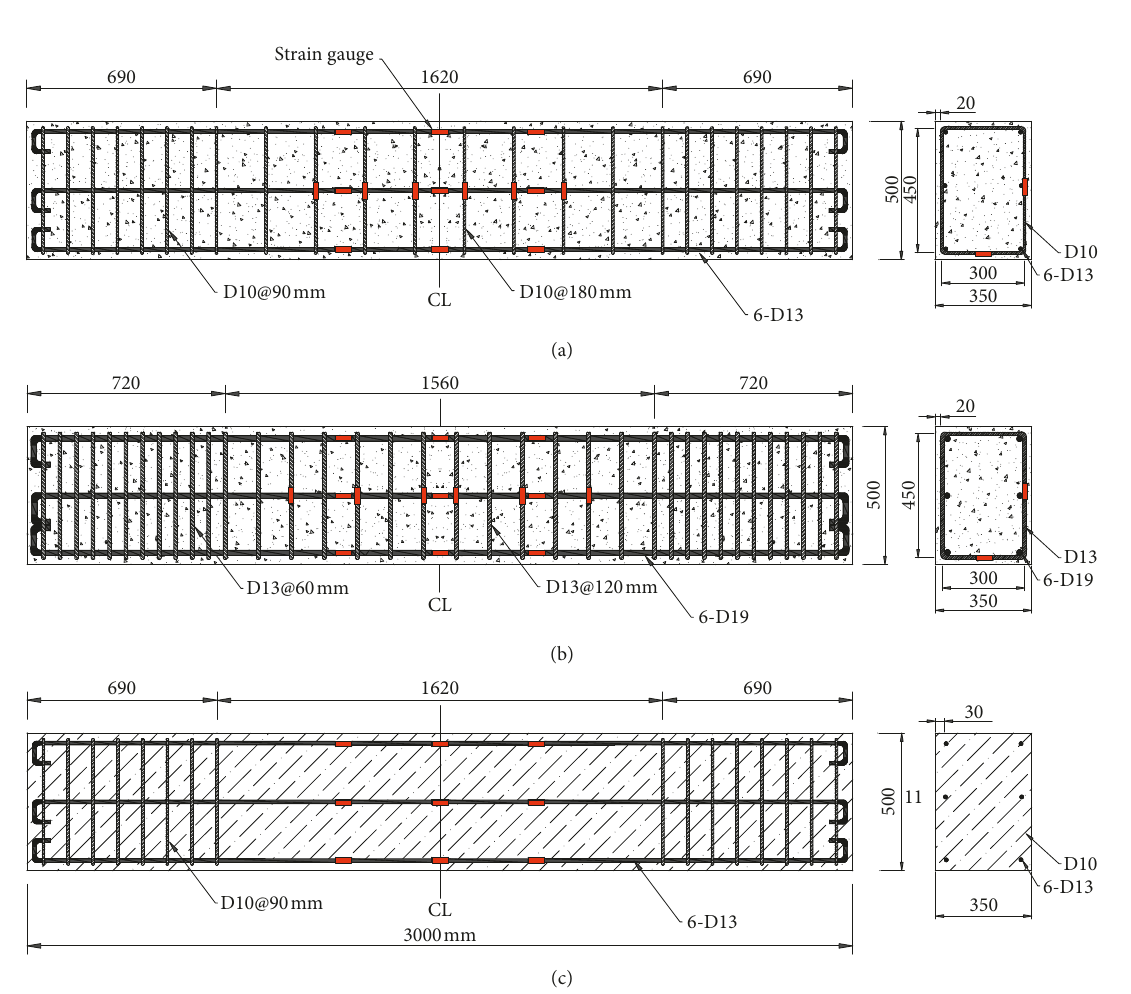
Figure 1: Details of specimens: (a) MT30-0.77; (b) MT40-1.89; (c) MTF25-N. Table 2: Mix proportion.